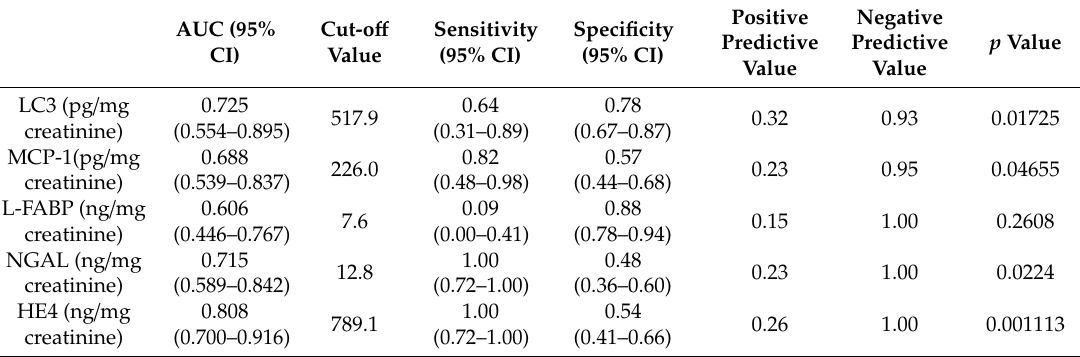
Table 2. Characteristics of the urinary biomarkers in subclinical acute rejection